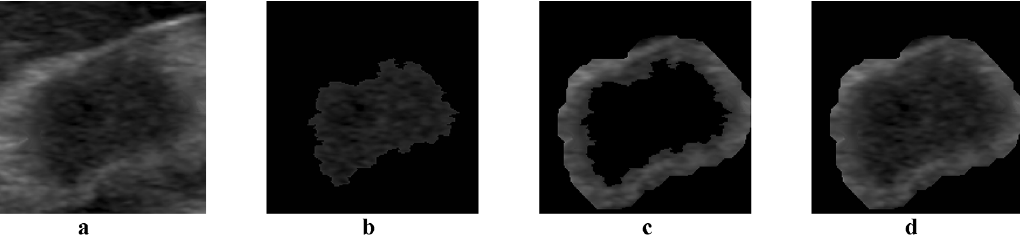
Figure 3. ROIs extracted from the cleaned-up image: ( a) original ROI, (b) intra-tumoral ROI, (c) peritumoral ROI and (d) combined